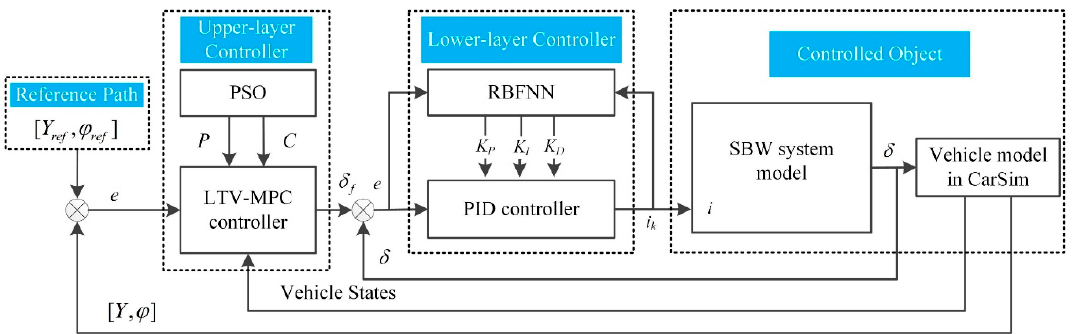
Figure 1. The diagram of the path tracking control system.